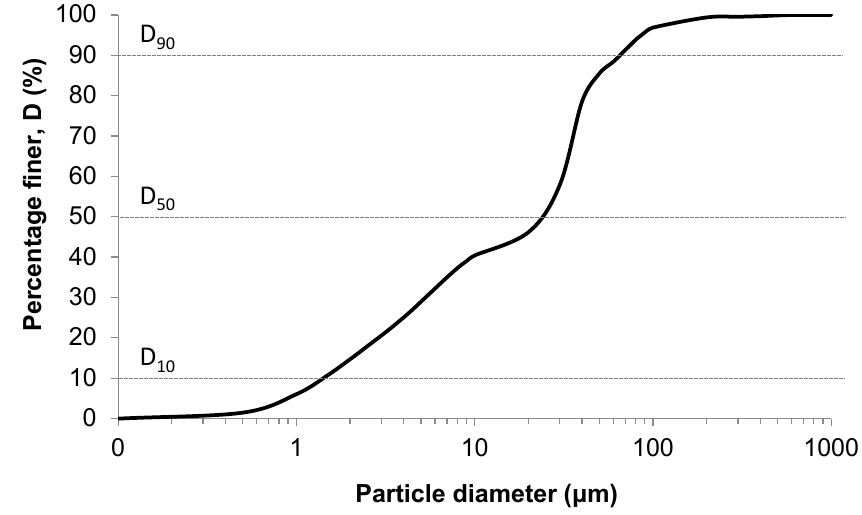
Figure A2. Particle size distribution of MK.